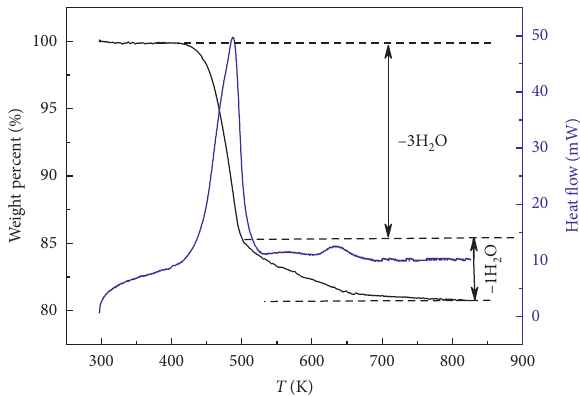
Figure 2: The TG and DSC curve of β -CsB